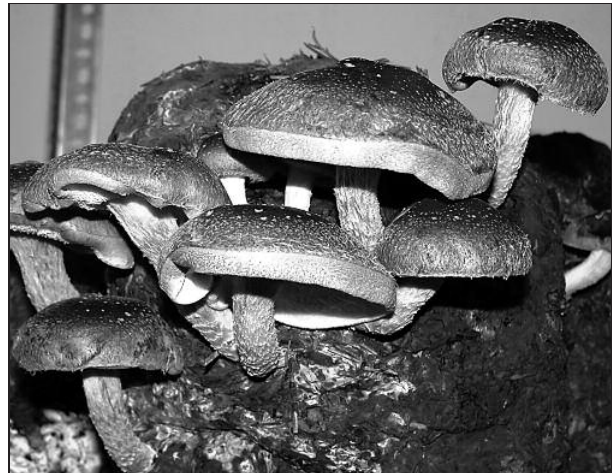
Figure 3. Shiitake (Lentinula edodes) DSCN 5162